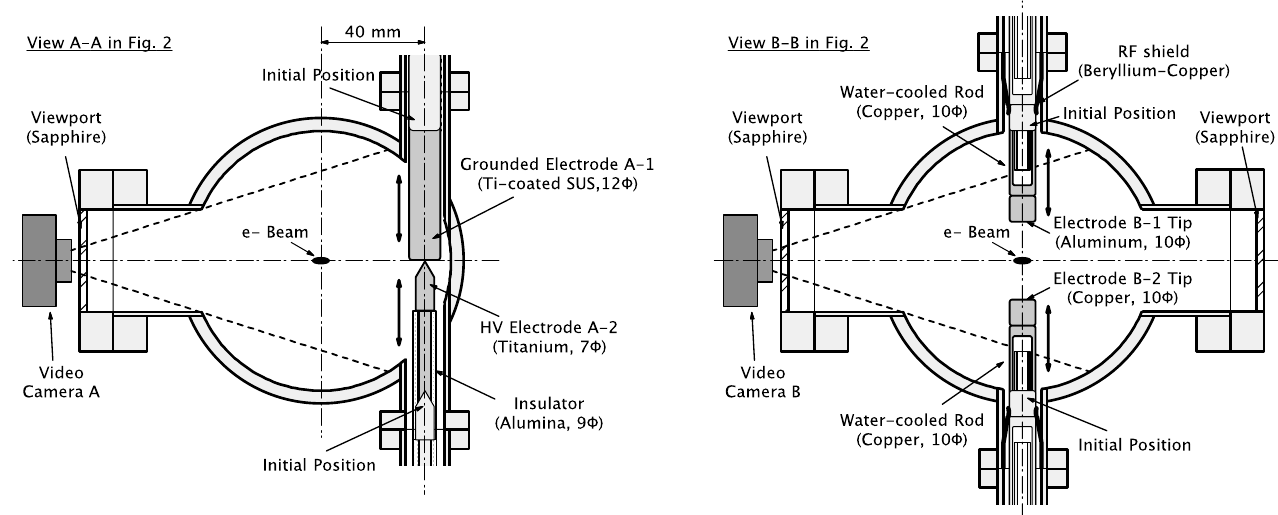
FIG. 3. Schematic representations of two types of electrodes. Electrodes on the left are used for the electric discharges caused by the applied DC HVs, and those on the right are used for the electric discharges caused by beam-induced rf